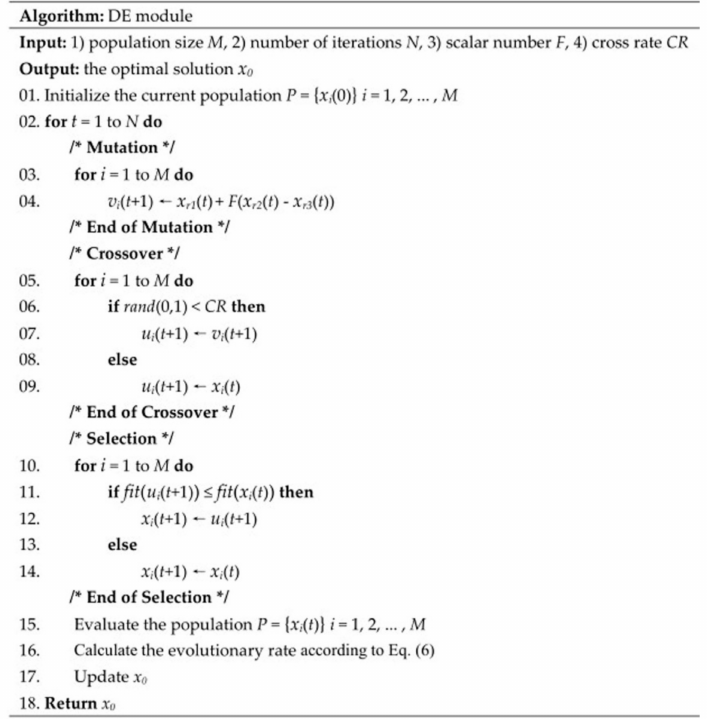
Figure 6. Pseudocode of DE